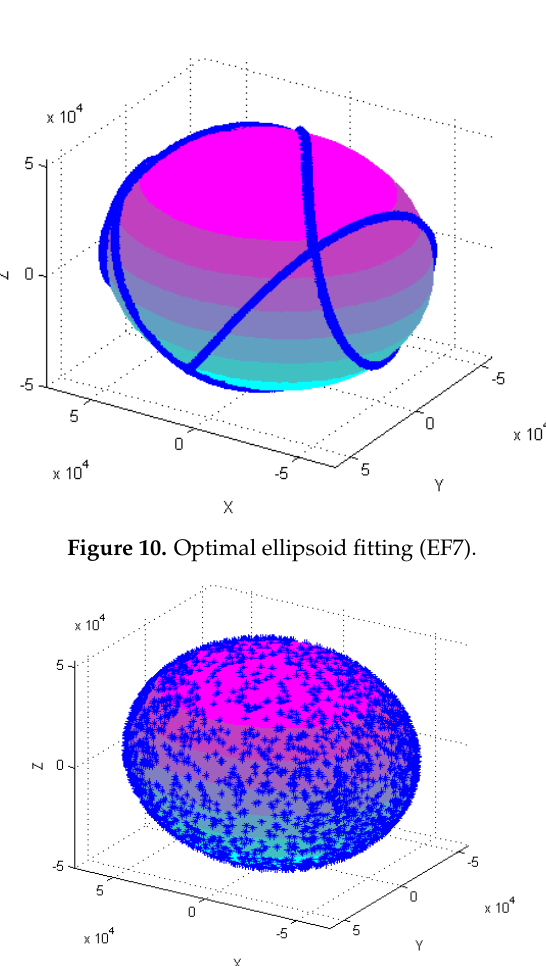
Figure 6. Optimal ellipsoid fitting (EF3) Figure 7. Optimal ellipsoid fitting (EF4). Figure 8. Optimal ellipsoid fitting (EF5). Figure 9. Optimal ellipsoid fitting (EF6).